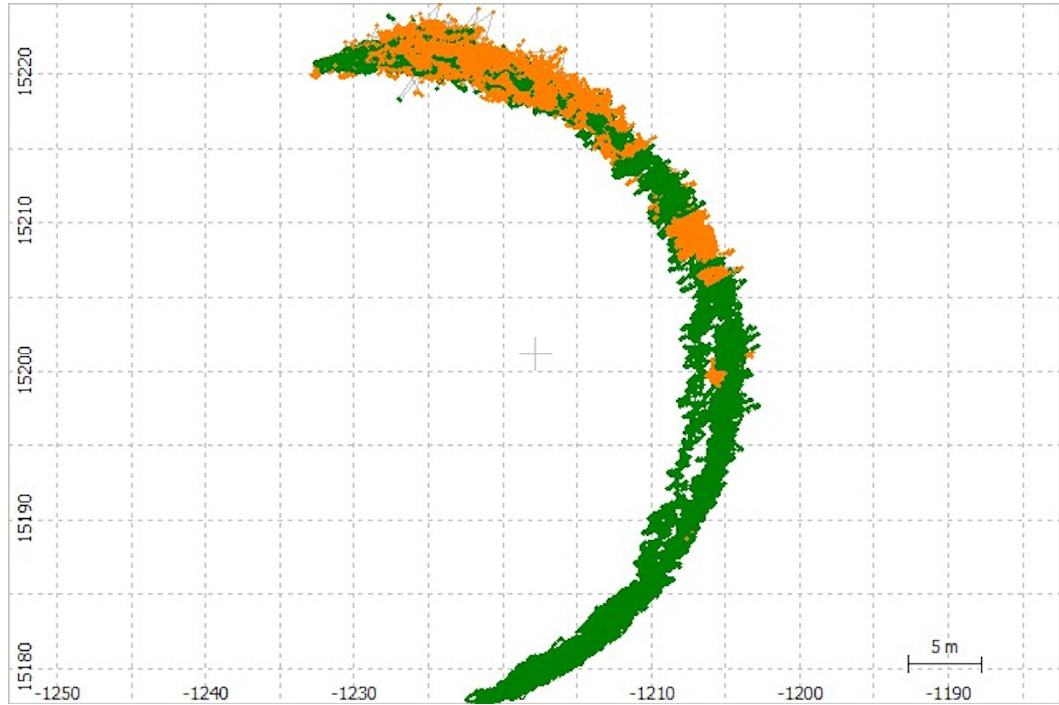
Figure 4. Buoy track during tidal cycle B, 29 August 2019 06:00–14:30. Fixed solutions (Q1) are shown in green, and float solutions (Q2) are shown in orange.